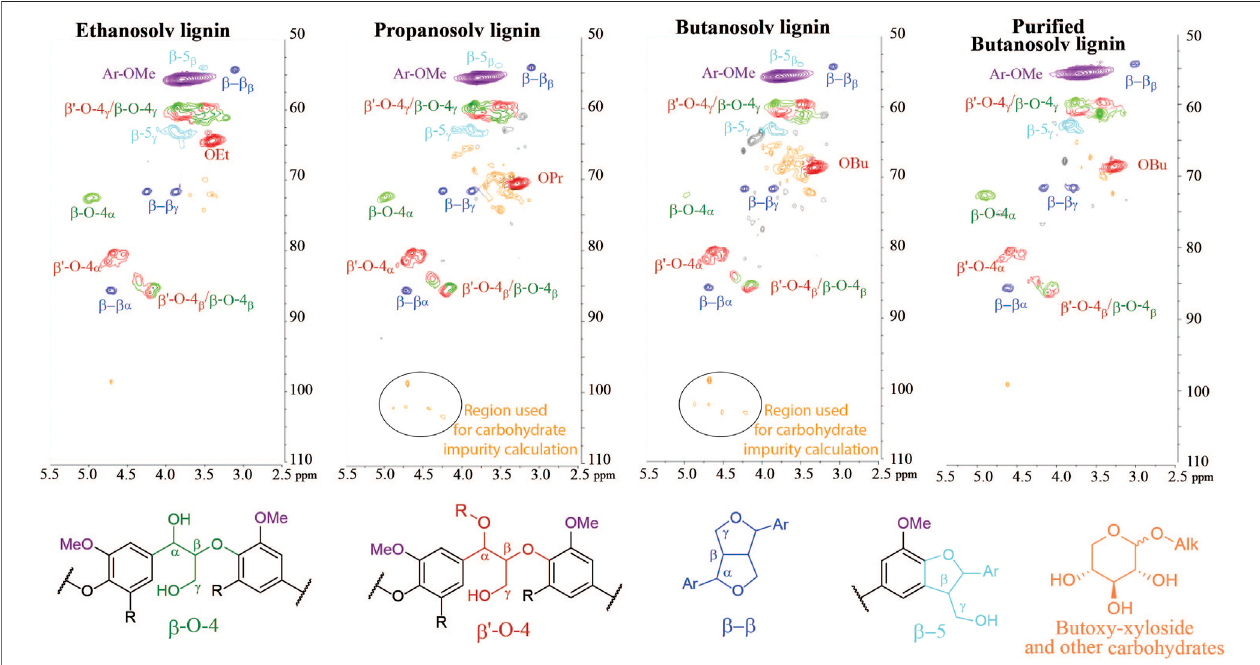
FIGURE4| 2DHSQCNMRspectra{[(2.5 – 5.5)(50 – 110)]ppmlinkageregion}ofethanosolv,propanosolv,andbutanosolvligninobtainedbythetraditionalwork-up method and puri fi ed butanosolv lignin isolated with a caustic soda treatment, showing a signi fi cant reduction in the carbohydrate